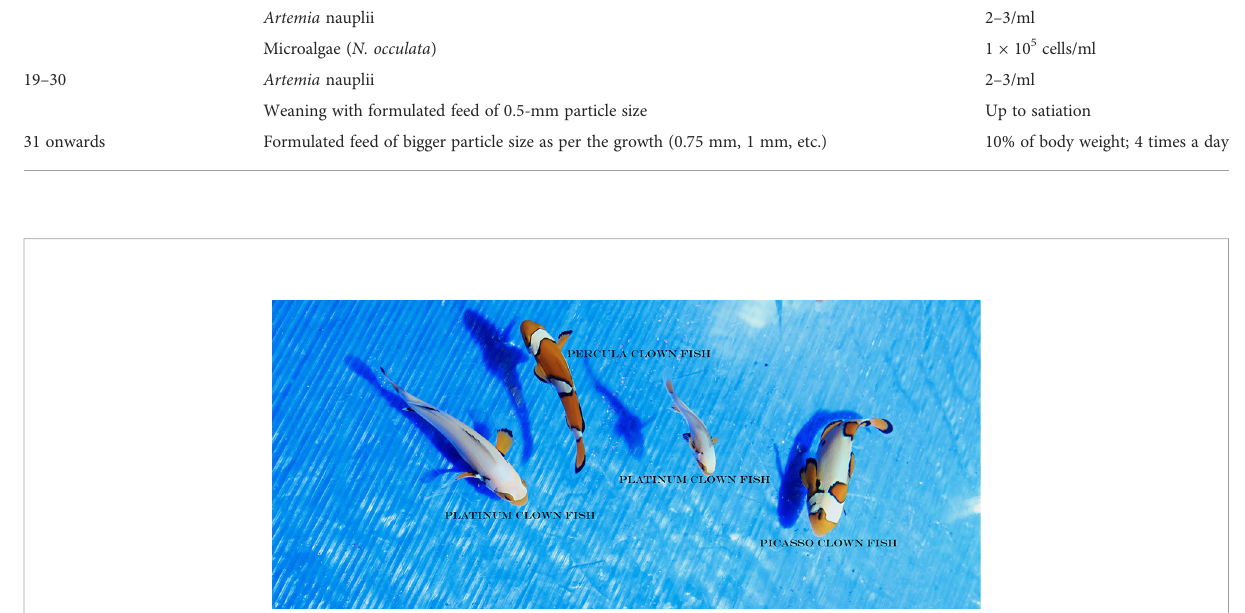
FIGURE 10 Designer clown fi shes Picasso and Platinum along with percula clown fi